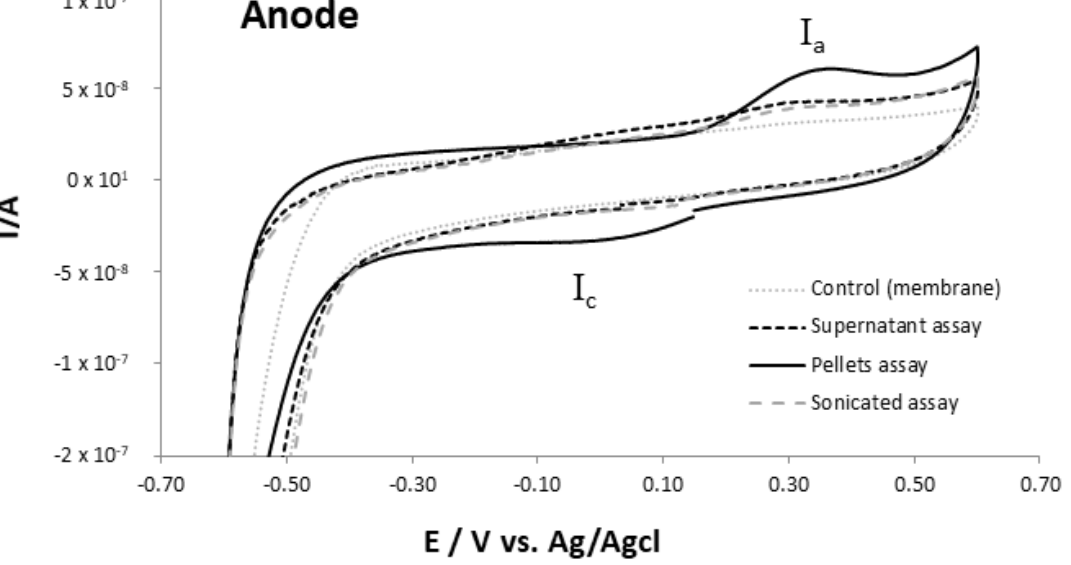
Figure 1. Ex situ cyclic voltametric features of the anodic chamber wastewater sample with bacteria cells in suspension; potential window between − 0.6 and +0.6 V; scan rate 20 × 10 − 3 V s − 1 ; full scale at SI (Figure S2).